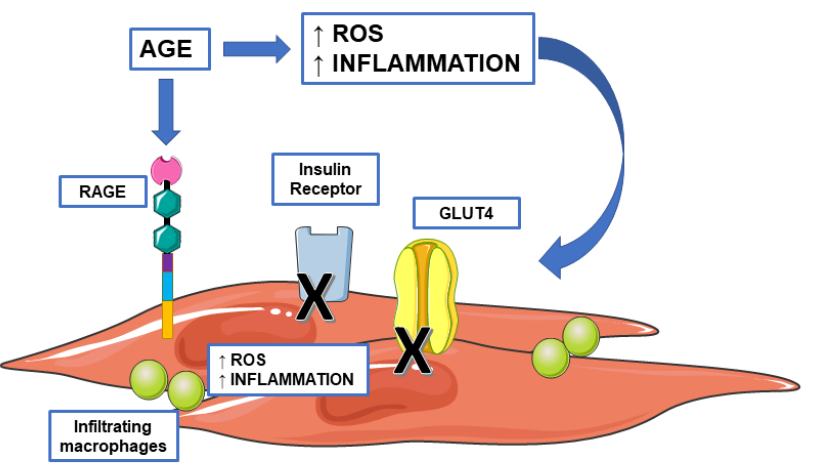
Figure 5. Advanced glycation end products (AGE) and insulin resistance. AGE can affect insulin signaling both directly and indirectly by increasing the circulating levels of reactive oxygen species and pro-inflammatory mediators. AGE can reduce insulin sensitivity by inhibiting the tyrosine kinase activity of the insulin receptor and reducing GLUT4 (Glucose Transporter Type 4) translocation. Accumulation of AGE overstimulates receptors for advanced glycation end product (RAGE) signaling which, along with contributing to fiber damage, recruitment of pro-inflammatory macrophages, and inflammation, may also exacerbate insulin resistance.